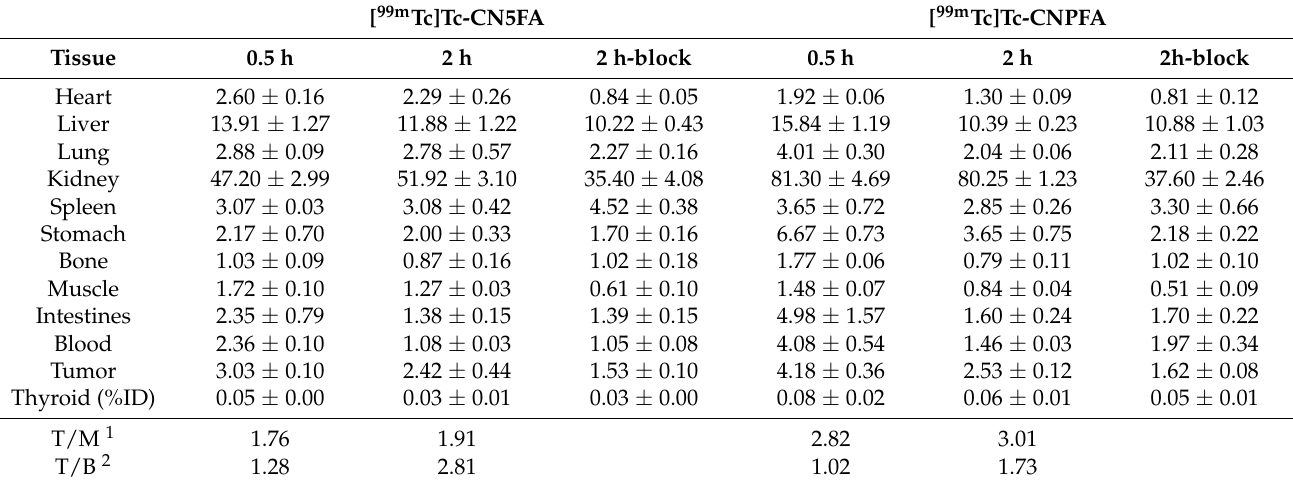
Table 1. Biodistribution of [ 99m Tc]Tc-CN5FA and [ 99m Tc]Tc-CNPFA (mean ± SD for n = 3).